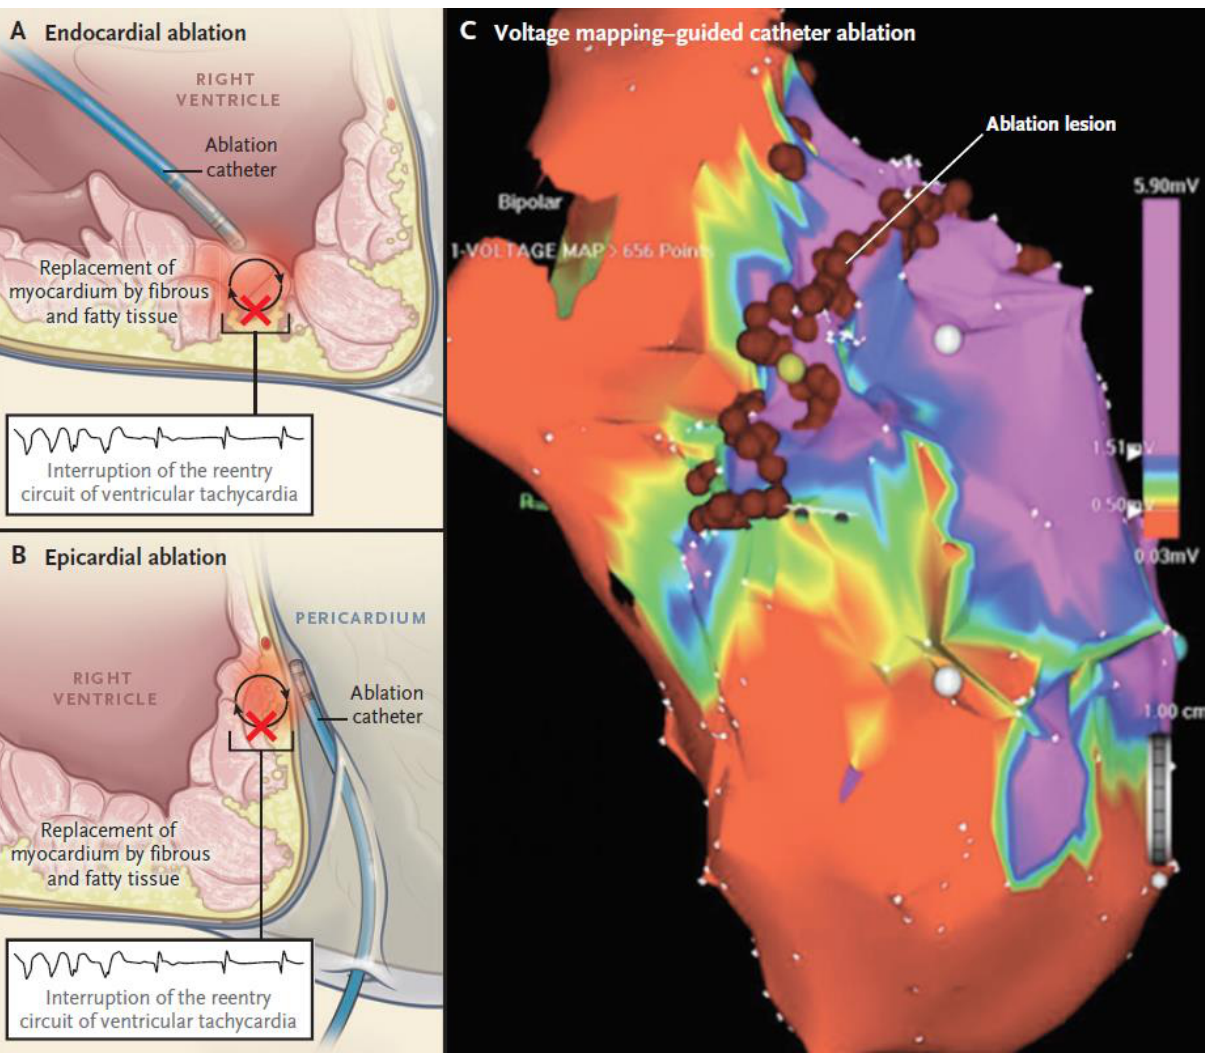
Figure 6. Catheter ablation in ACM patients. Panel ( A ) shows the subendocardial approach. Panel ( B ) shows the subepicardial approach. Panel ( C ) shows three-dimensional electro-anatomical voltage mapping to reconstruct regions of right ventricular scarring. ACM = arrhythmogenic cardiomyopathy. From The New England Journal of Medicine, Domenico Corrado, Mark S. Link, Hugh Calkins, Arrhythmogenic Right Ventricular Cardiomyopathy. New Engl. J. Med. 2017, 376, 61–72. Copyright © 2021 Massachusetts Medical Society. Reprinted with permission [44].